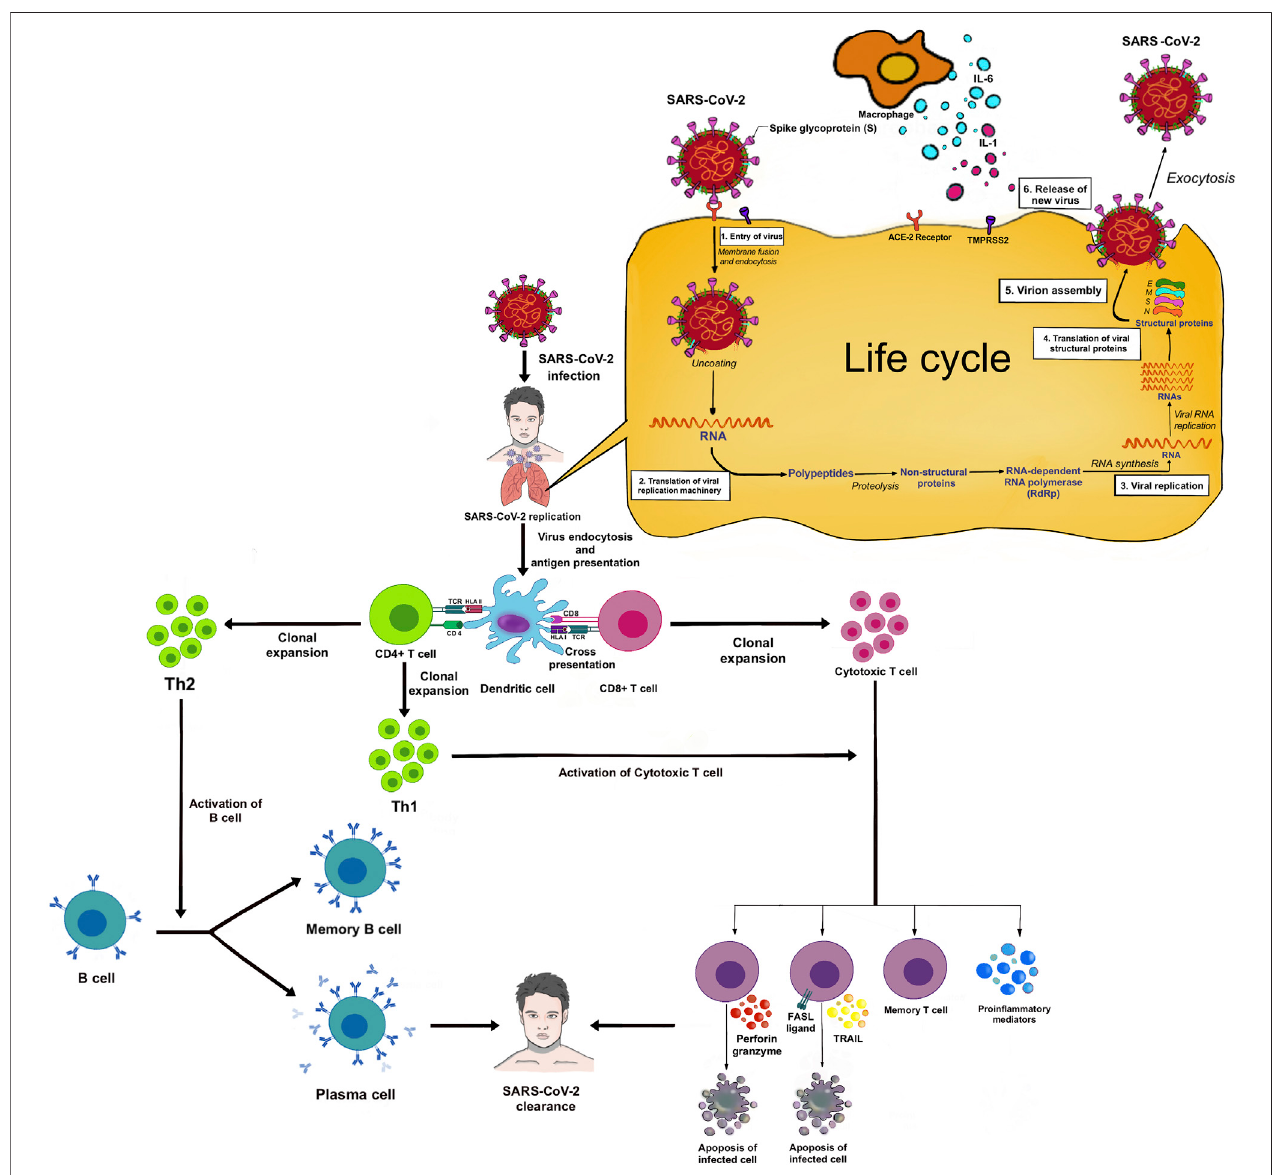
FIGURE 1 | SARS-CoV-2 entry and human immune